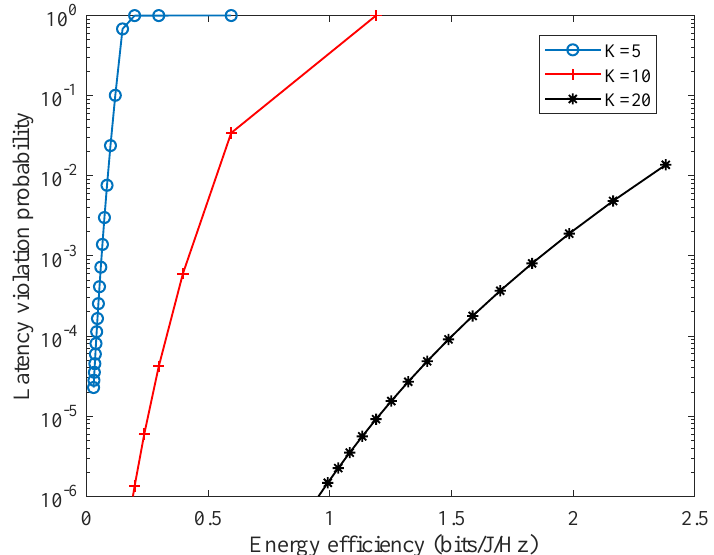
Figure 11. Relationship between latency violation probability and energy